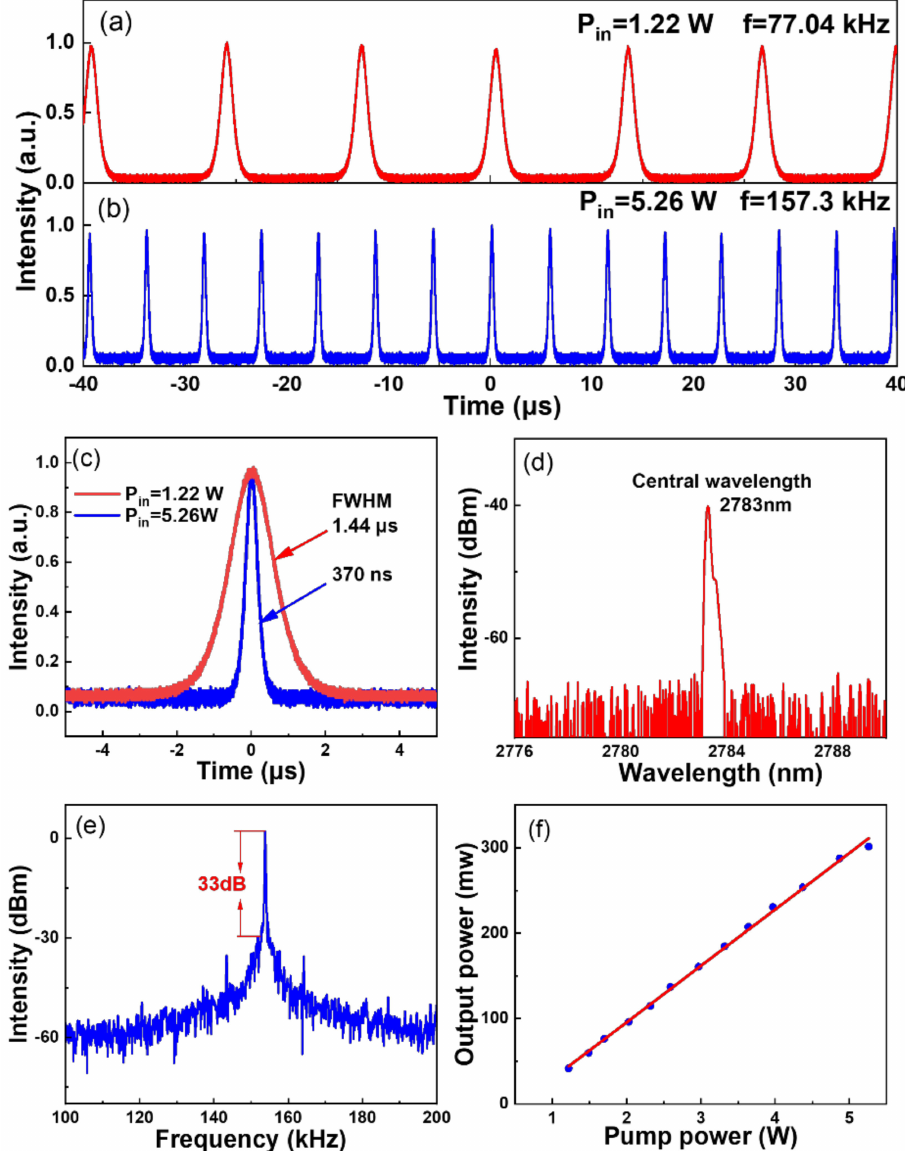
Figure 4. Q-switched pulse trains using the Mo 2 Ti 2 C 3 T x -SAM at the pump power of ( a ) 1.22 W and ( b ) 5.26 W, and ( c ) the corresponding single-pulse waveforms. ( d ) The optical spectrum of the Q-switched pulses and ( e ) the measured radio frequency at the pump power of 5.26 W. ( f ) The linear relationship between pump power and output